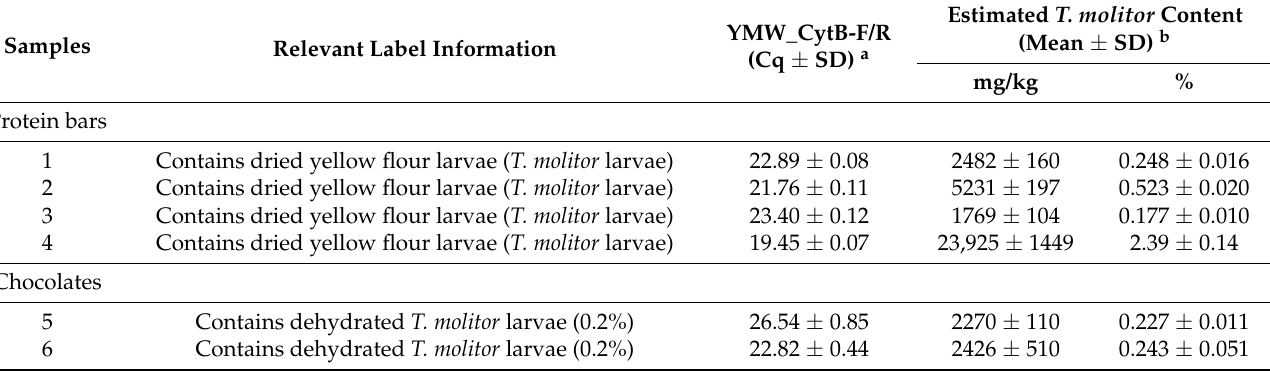
Table 4. Results of the application of the quantitative real-time PCR using biscuits model mixtures to detect and quantify yellow mealworm in commercial